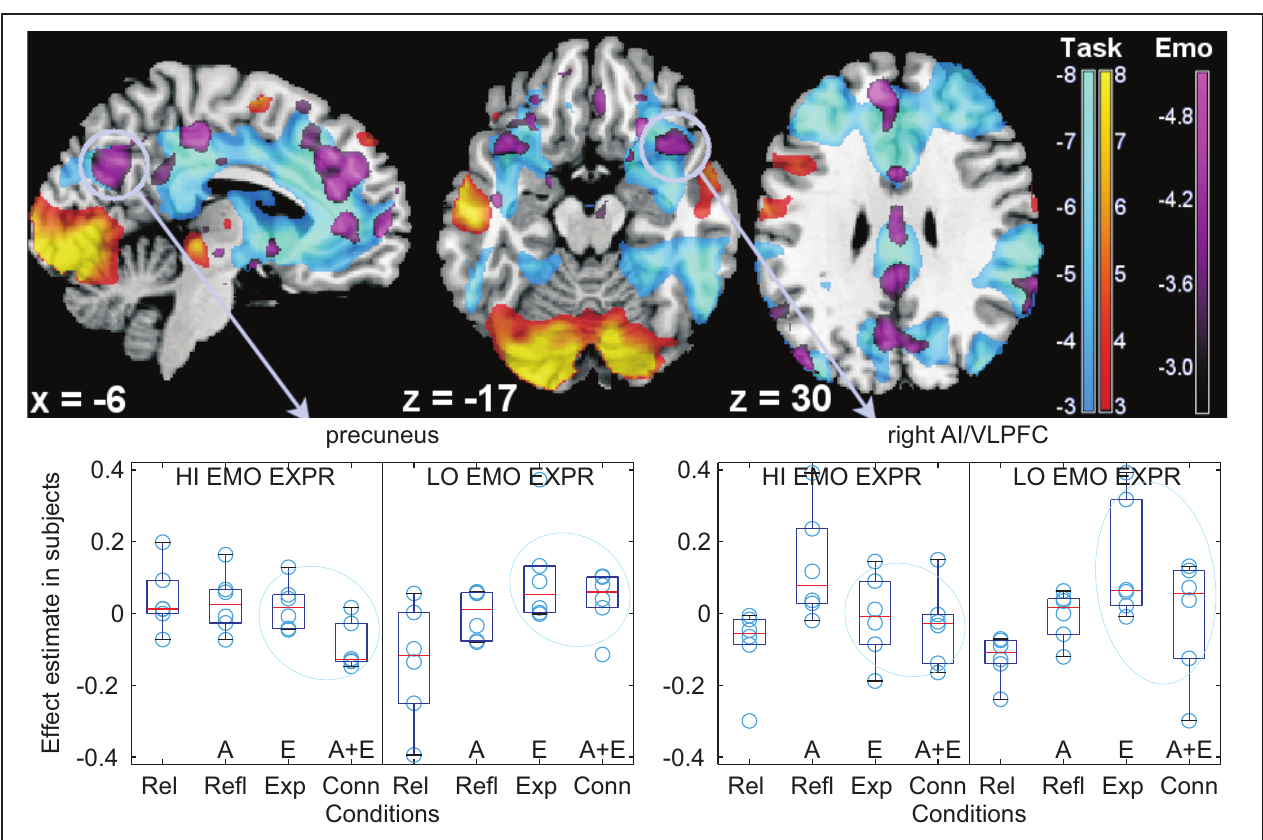
FIGURE 3 | Individual differences in the use of emotional words. Top: modulation of deactivations by individual differences in the tendency to use emotional words in the medial aspect of the cortex (left), in the orbitofrontal cortex (centre), and at the level of the angular gyrus (right), shown as parametric maps of t -values overlaid on a template T1-weighted brain. Activations and deactivations of the main reading task are displayed in yellow/orange and light blue, respectively, thresholded for display purposes at p = 0 . 005, uncorrected. In violet, the modulation by individual differences, at threshold p = 0 . 01, uncorrected, of the emotional contrast. The left side of the transversal slices is on the left. Bottom: box-plots of signal differences between conditions, displayed separately in subjects with high and low use of emotional words (“HI EMO EXPR”, “LO EMO